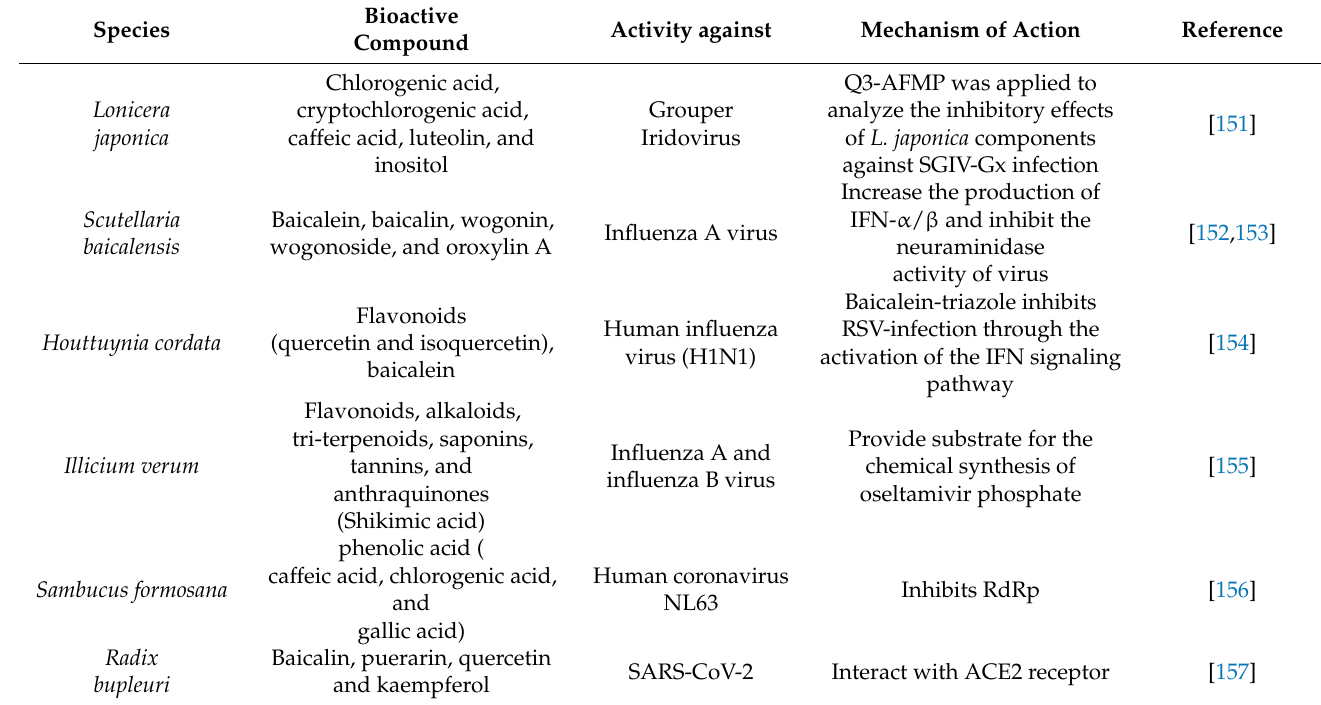
Table 2. Chinese herbal and bioactive compounds with antiviral